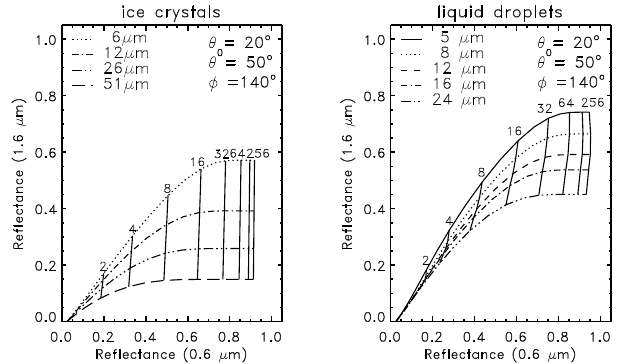
Fig. 2. The Nakajima and King (1990) retrieval method. Each curve shows the values of reflectances at 0.64 and 1.63 µ m for a certain value of r eff as a function of COT (indicated by the mostly vertical lines). Thus, from a combination of these reflectances both the COT and r eff of a The effective radius values in the forward model lookup table were chosen to reflect the range in values in the RACMO climate model. a cloud can be determined. The left panel shows the retrieval curves for ice crystals, the right panel for water droplets; the viewing geometry is indicated in the upper right of each panel, with θ 0 the solar zenioth angle, θ the satellite zenith angle and φ the relative azimuth angle. A surface albedo of 0 was used for these diagrams. Table 1. Details of the lookup tables used in the forward model and the CPP retrieval algorithm. Forward model CPP